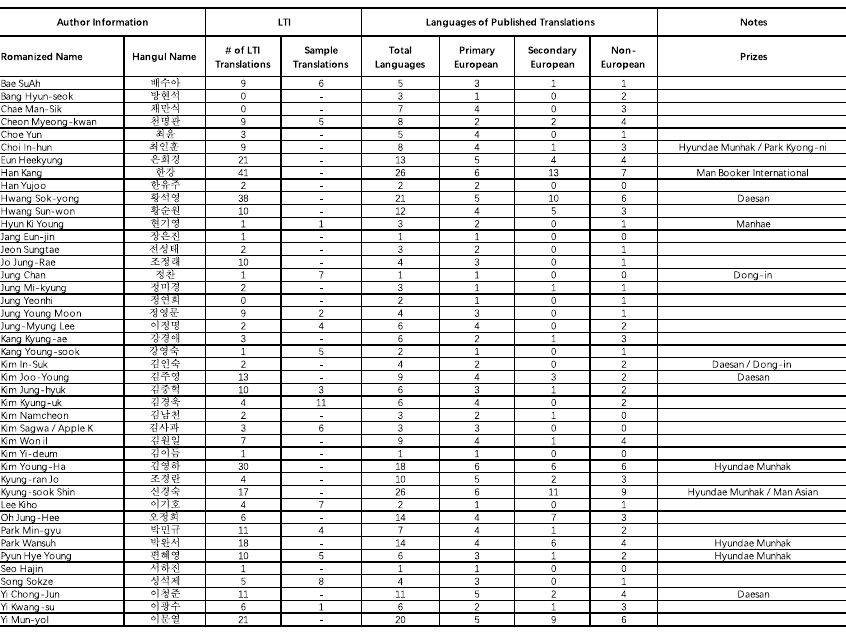
Table 1 Number of translations of works by major writers,